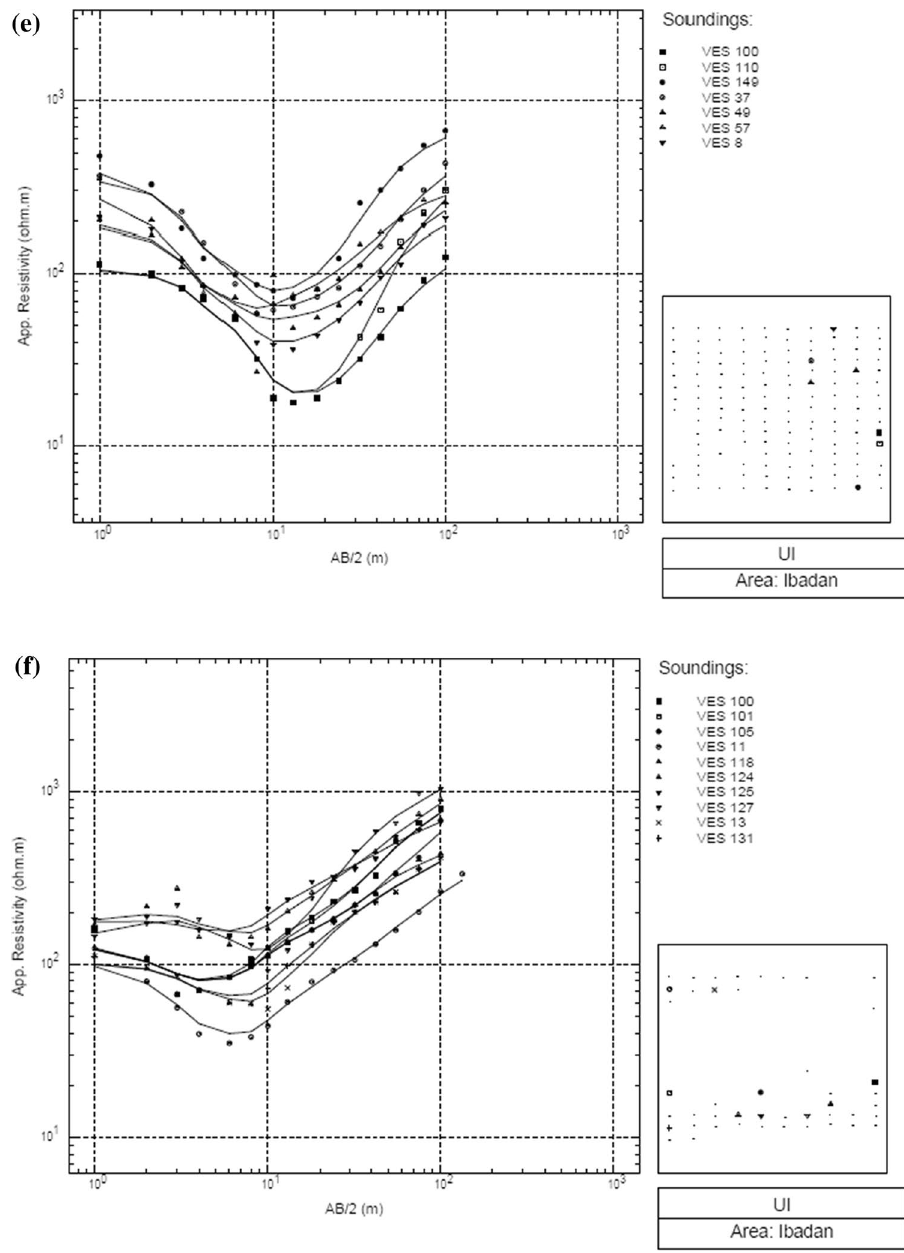
Groundwater potential map of the study area